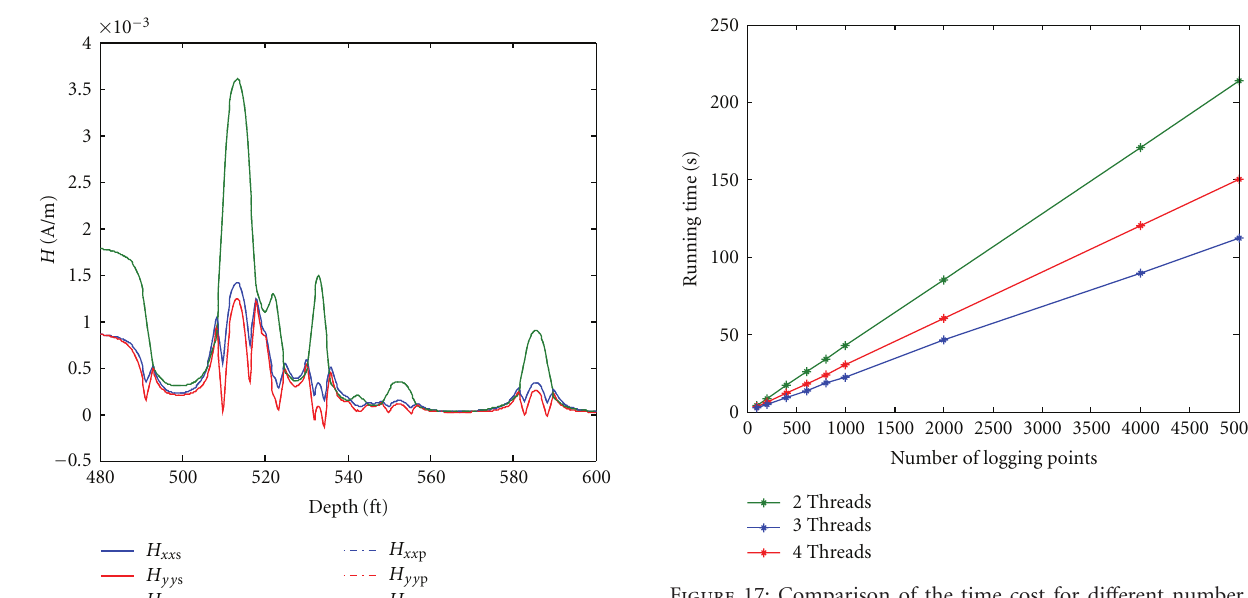
Figure 17: Comparison of the time cost for di ff erent number of threads.